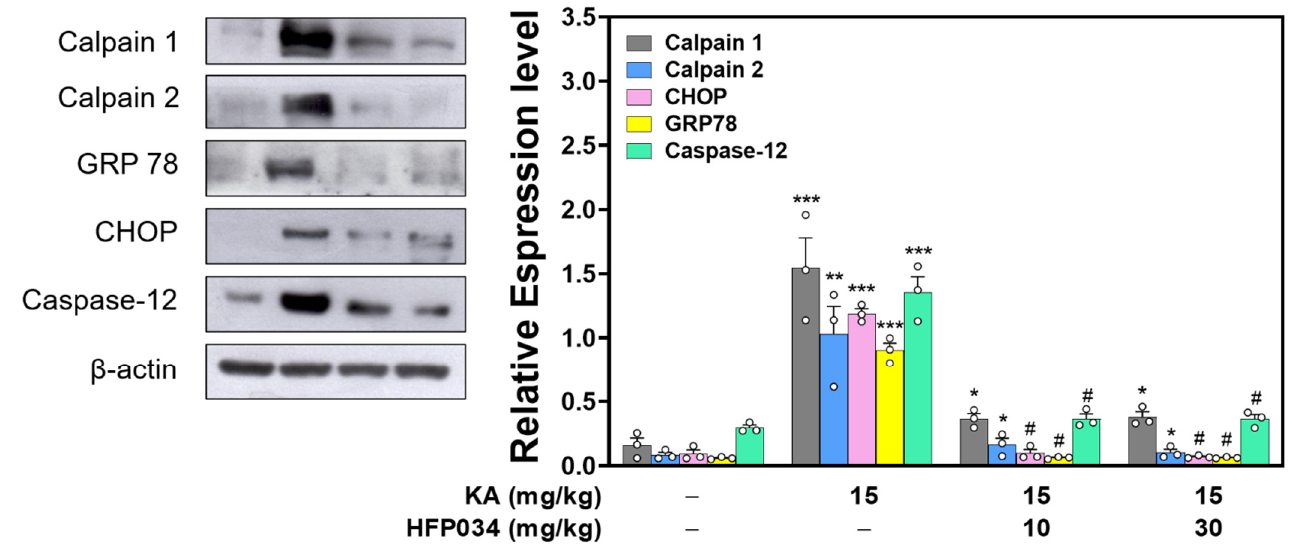
Figure 6. Effect of HFP034 pretreatment on the expression levels of ER stress-associated proteins, calpains, GRP78, CHOP, and caspase-12 in the hippocampus of rats with KA. Each dot represents the value for an individual experiment. Data are presented as mean ± S.E.M. n = 3 rats for each group. ** p < 0.01 , *** p < 0.001 versus control group. * p < 0.01, # p < 0.001, versus KA group.